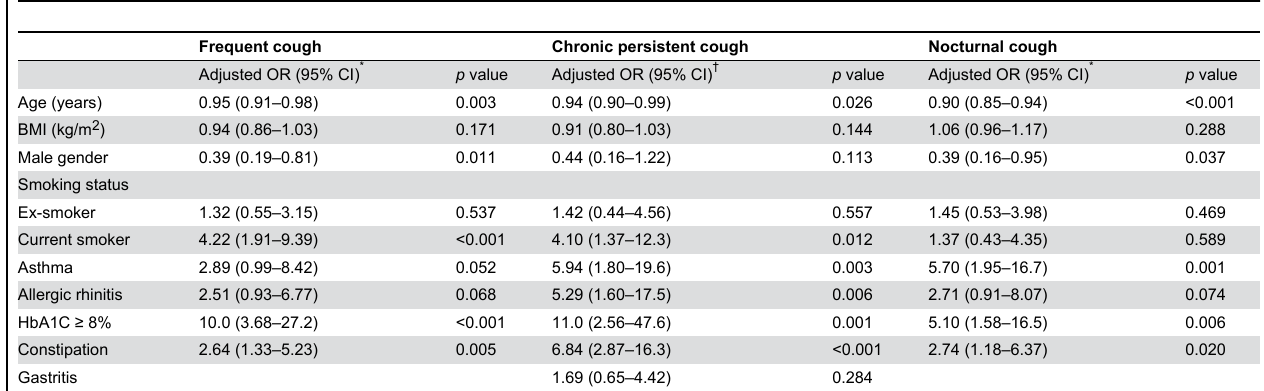
Table 4. Further adjusted logistic regression models for cough and comorbidity